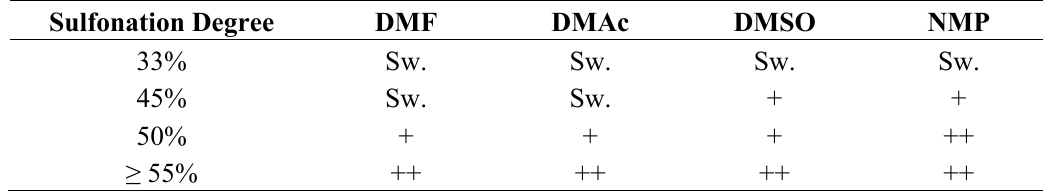
Table 2. Solubility of different sPEEK samples in different organic solvents (Sw. = swelling, + = partial solubility, ++ = complete